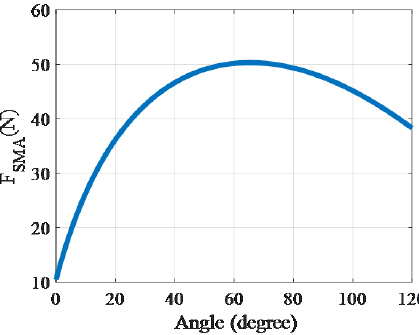
Figure 5. The force required for elbow motion.